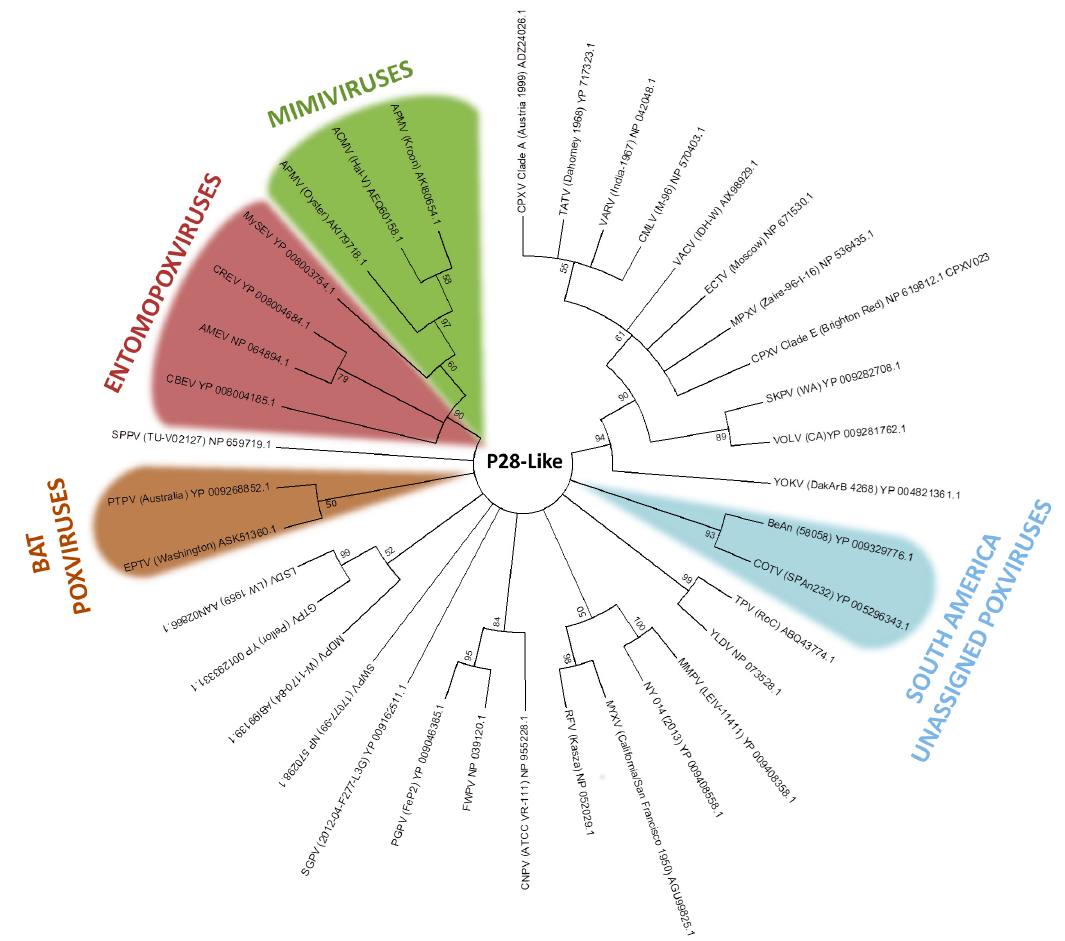
Figure 4. Phylogenetic relationship of p28-like genes. The tree was generated from a multiple protein sequence alignment of the indicated sequences using the maximum likelihood method. A bootstrap of 1000 was used, and support >50 is indicated above the branches.